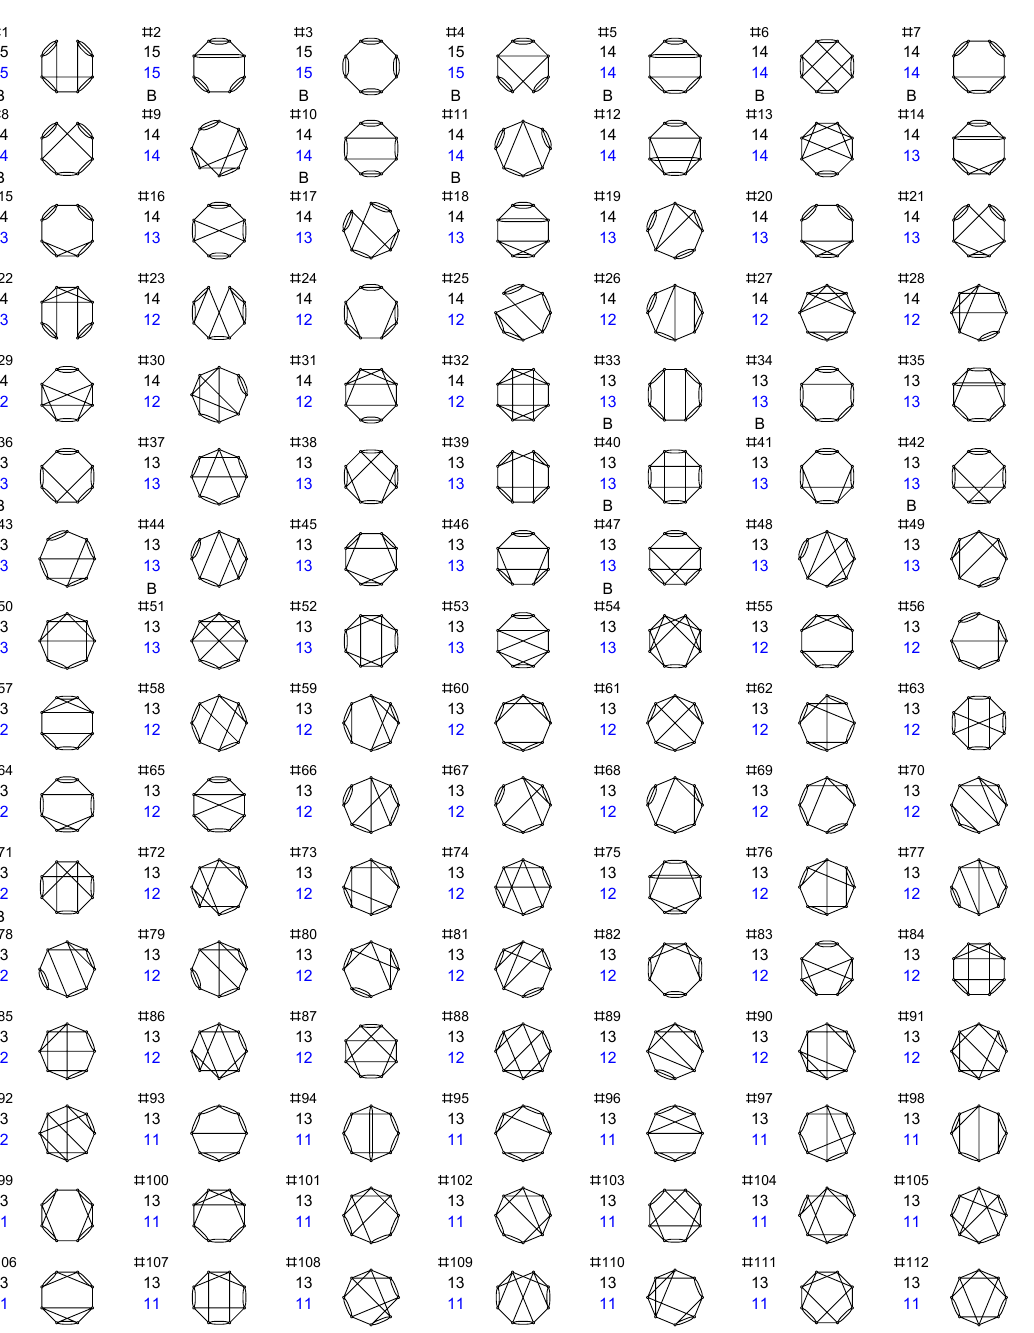
Figure 8 . (Part 1 of 2) All vacuum diagrams of order g 8